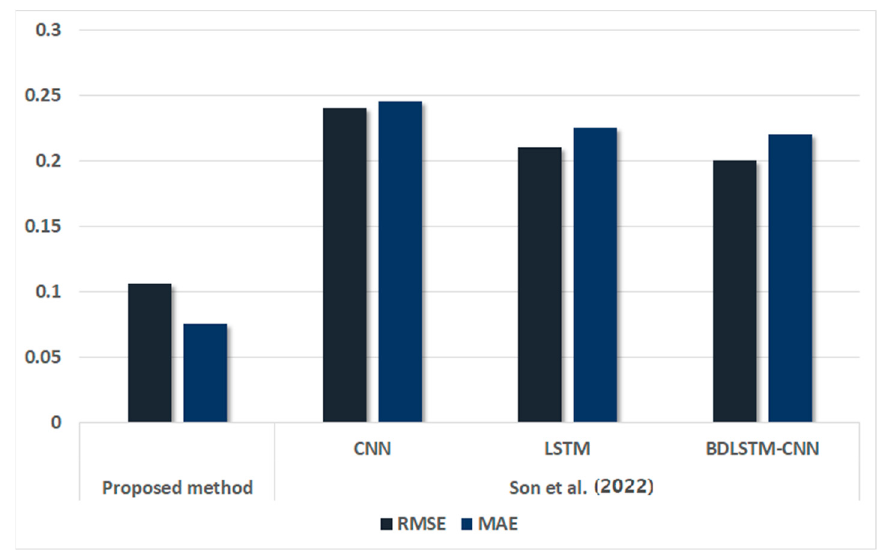
Figure 9. Comparison of results with other prediction